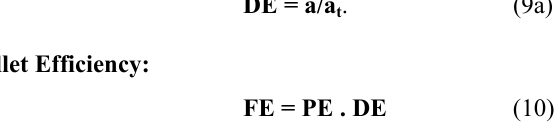
Fig. 11a,b,c. The same regime but different weld deposi- tion shapes and different DE that evaluates waste of